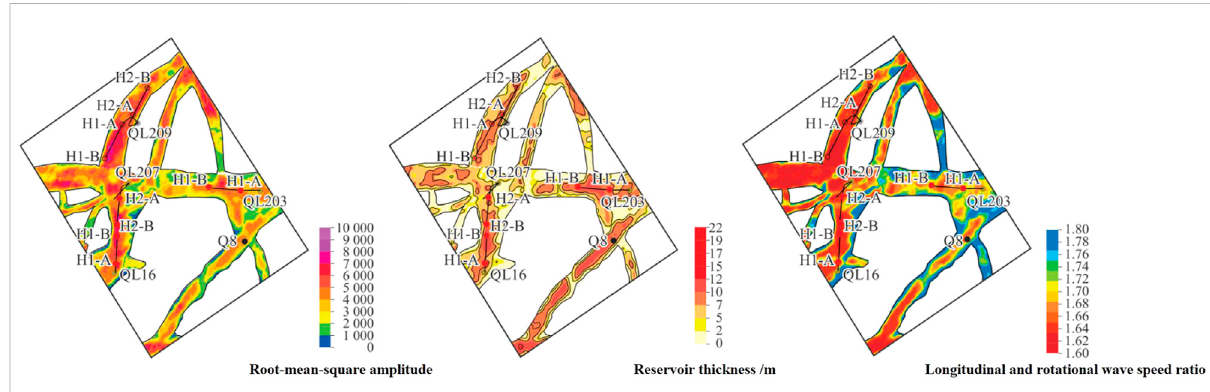
FIGURE 1 Three dimensional carving stereogram of channel sand body of Shaximiao Formation in Central Sichuan.